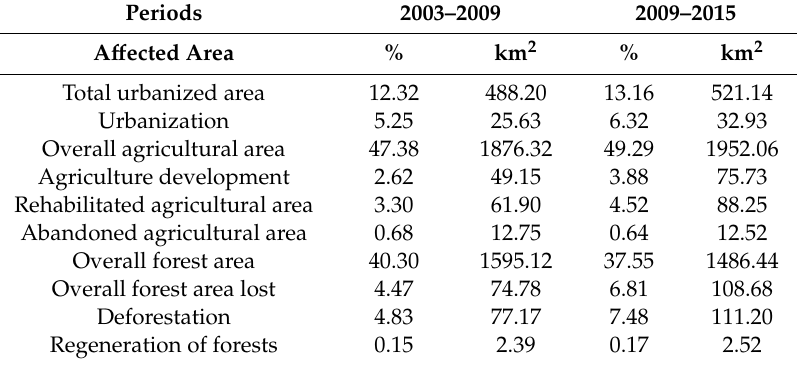
Table 11. Global indicators of land use change on the Algerian coast. Source: National Statistics O ffi ce of Algeria. The change is expressed as absolute value (column labeled “km 2 ”), and share of the coastal municipalities (column labeled